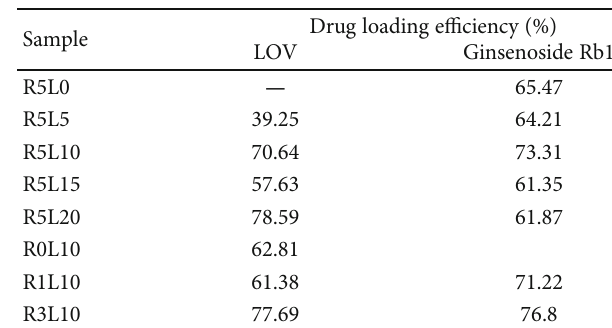
Table 6: Loading e ffi ciency of Lov and ginsenoside Rb1 by AG/CS polymer blend with di ff erent initial content of Lov